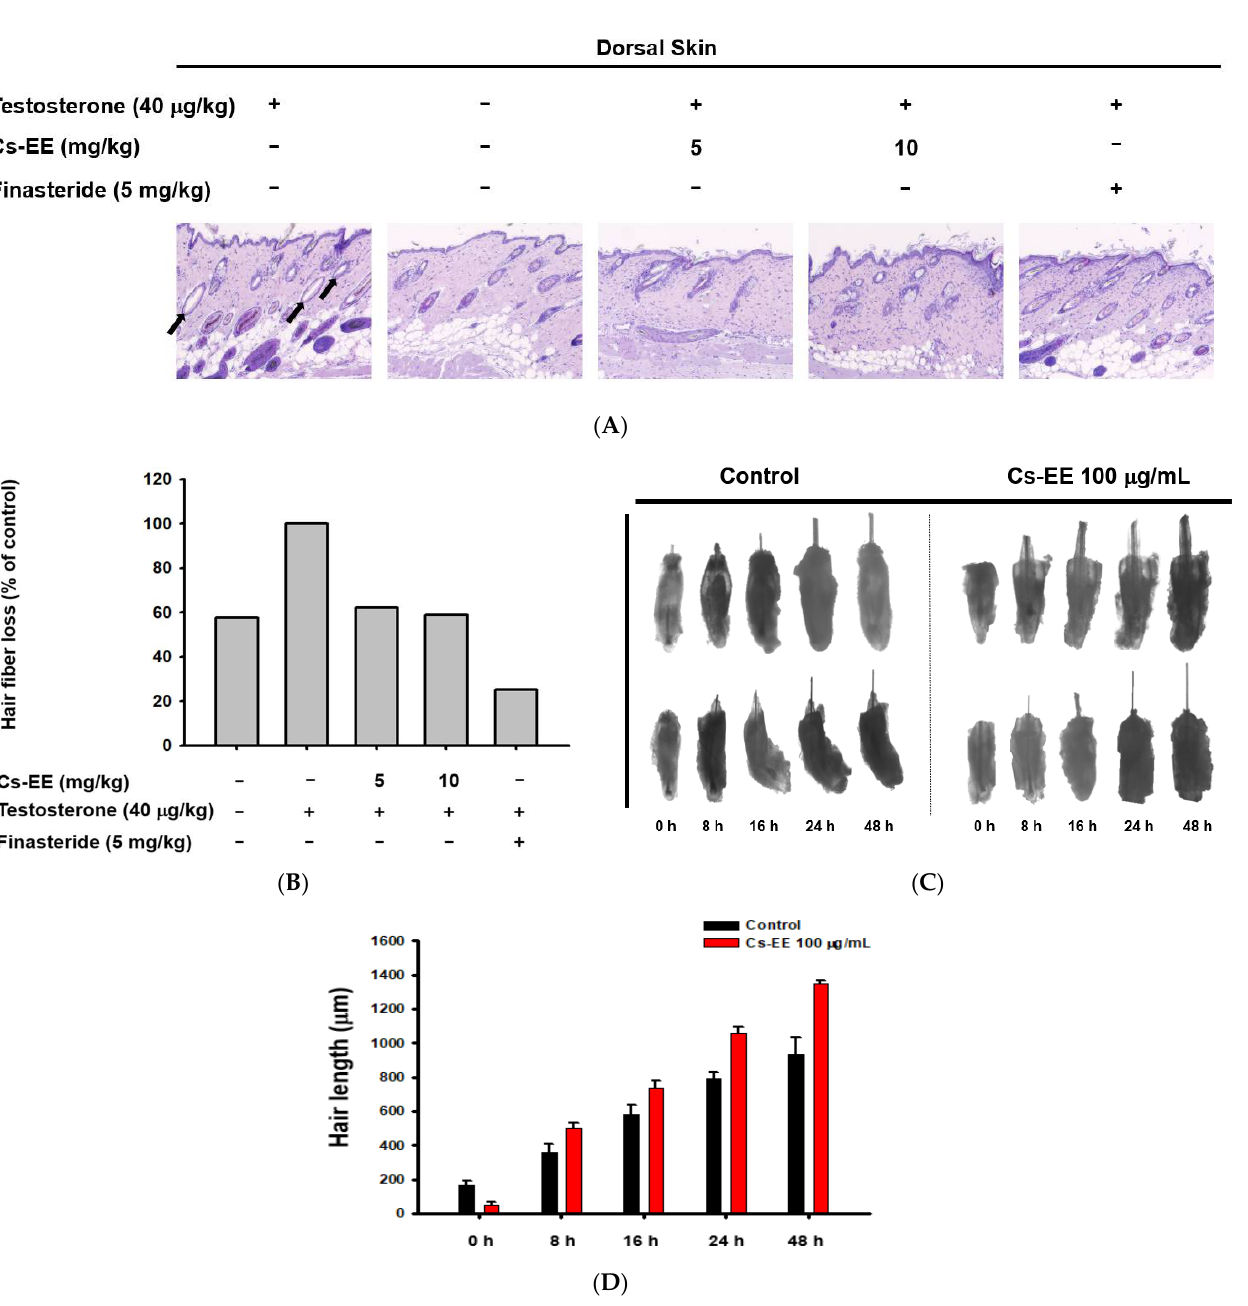
Figure 3. Effect of CS-EE on hair growth within ex vivo mouse hair follicles. ( A ) H&E staining of mouse skin tissue under 4× magnification. ( B ) The ratio of hair fibers that degraded (black arrows in ( A )) to all hair fibers was calculated and expressed. ( C ) Representative images of mouse hair follicles cultured in dermal papilla cell medium with DMSO vehicle or Cs-EE (100 μg/mL). ( D ) The length of hair in each follicle was recorded and compared.